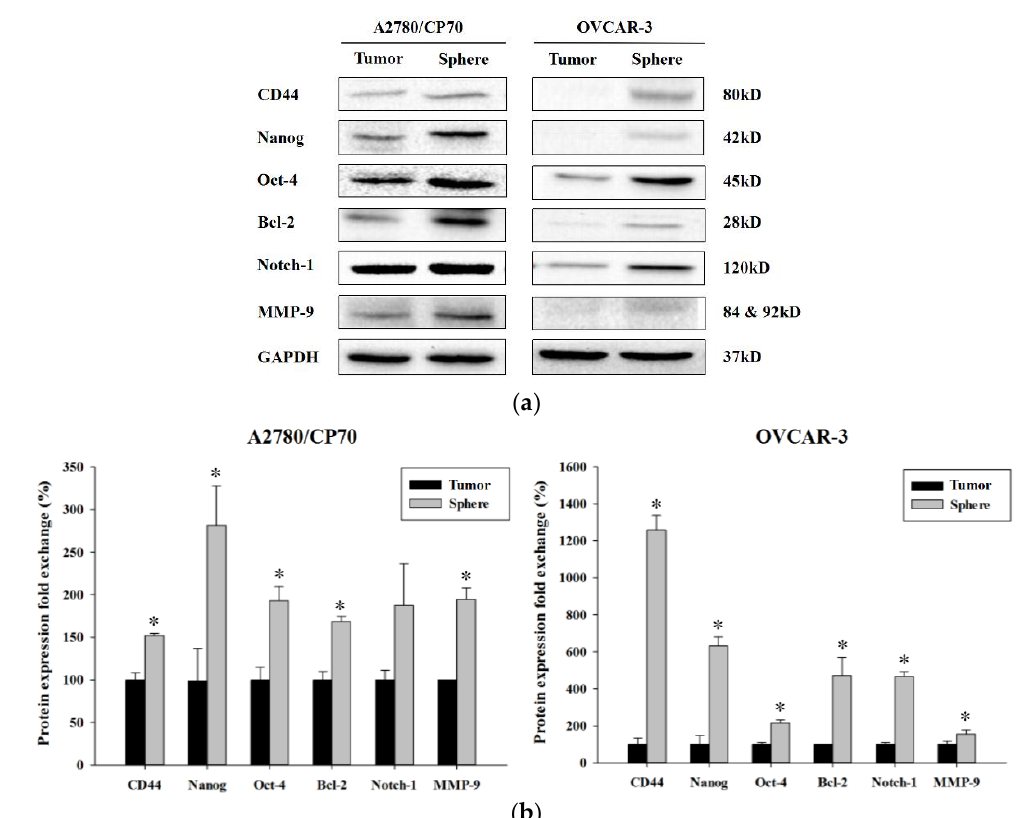
Figure 4. Sphere cells (3-weeks) from A2780/CP70 and OVCAR-3 cell lines possess the stemness properties. ( a ) the results of protein strips of CD44, Nanog, Oct-4, Bcl-2, Notch-1 and MMP-9 proteins; ( b ) both A2780/CP70 and OVCAR-3 sphere cells had marked higher expression of CD44, Nanog, Oct-4, Bcl-2 and MMP-9 proteins compared with tumor cells. Data was expressed as the number of spheres and shown as mean ± SD ( n = 3), * = p ≤ 0.05.